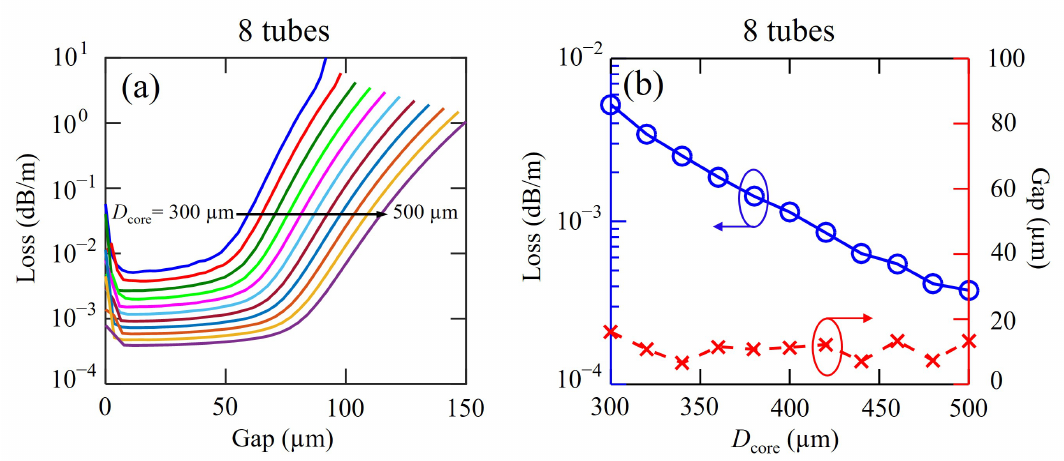
Figure 5. ( a ) Loss as a function of the gap in fibers with different core diameters. ( b ) Minimum loss and the corresponding gap in fibers with different core diameters. The number of cladding tubes is eight.